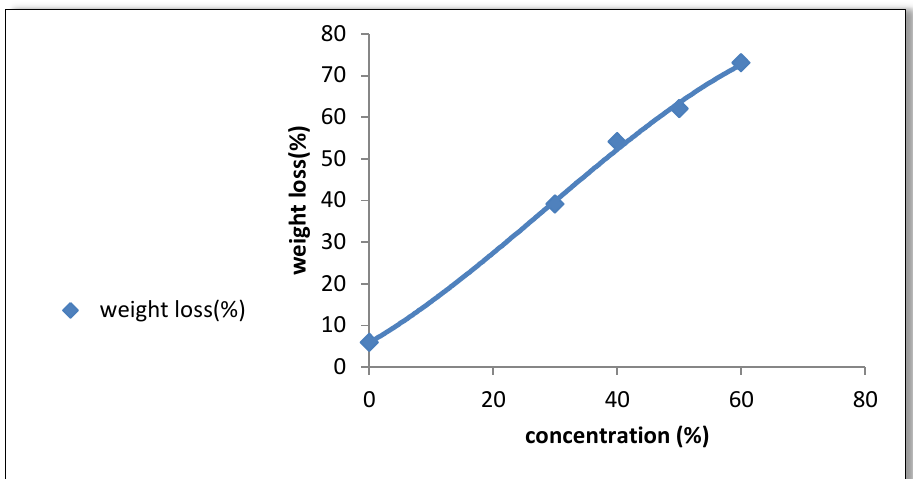
Fig. 4: Enzymatic degradation of starch/PVA blend